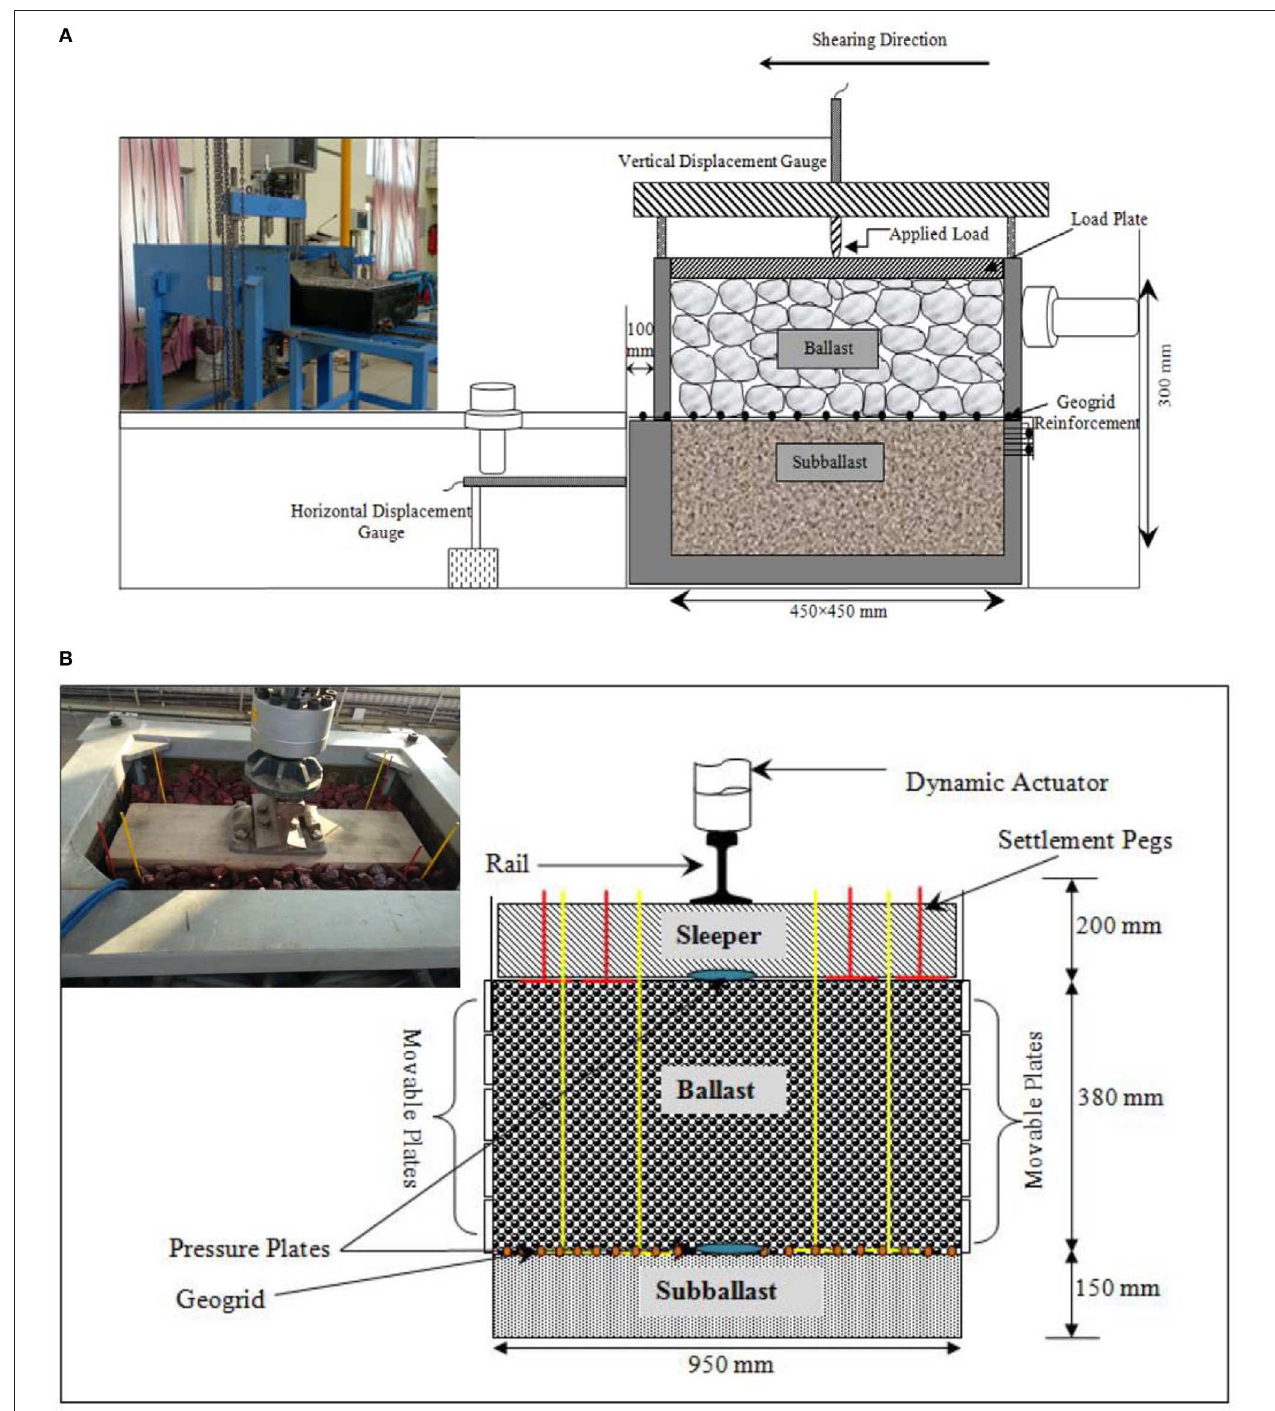
FIGURE 2 | Schematic illustrations of (A) direct shear apparatus and (B) process simulation test (PST) apparatus.